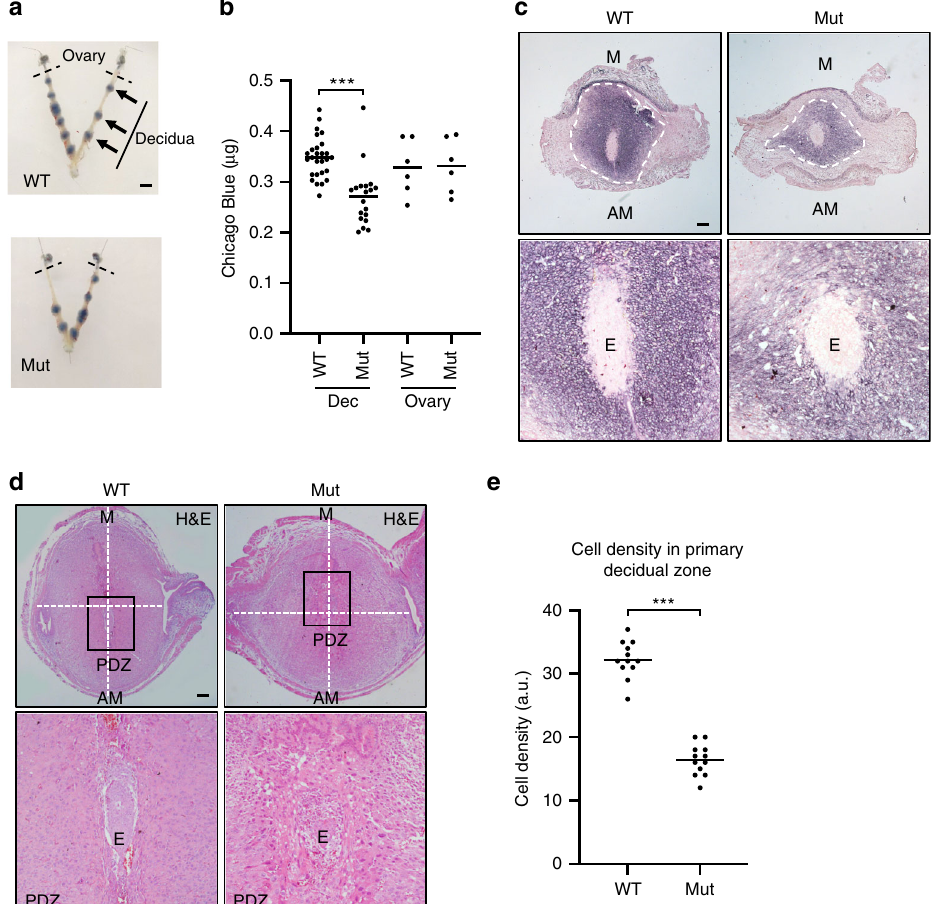
Fig. 2 Blimp1 mutants are receptive to implantation but display gross decidual and embryonic defects. a Sites of decidualisation at E6.5 appear grossly similar between wild-type and Blimp1 mutant uteri, as visualised by Chicago Blue dye injection ( n = 3 per group). b Chicago Blue content is reduced in decidua but not the ovaries of mutants (0.271 ± 0.013 μ g/decidua) in comparison to wild type (0.348 ± 0.008 μ g/decidua) mice. Data from 3 Blimp1 mutant mice (19 deciduae and 6 ovaries) and 3 wild-type mice (27 deciduae and 6 ovaries) are shown. Bars represent mean. Two-tailed unpaired Student ’ s t -test *** p = 3.49 × 10 − 6 . Source data are provided as a Source Data fi le. c Alkaline phosphatase staining of wild-type and Blimp1 mutant E5.5 decidua shows a reduction in intensity and the spread of alkaline phosphatase staining in Blimp1 mutant decidua indicative of impaired decidualisation ( n = 3 decidua per genotype). d H&E staining of E6.5 deciduae. Embryos in Blimp1 mutant mice are highly abnormal and display mis-localised implantation ( n = 4 decidua per genotype). e Cell density analysis of DAPI-stained nuclei identi fi es reduced cell density in the PDZ of Blimp1 mutants. Data from 12 tissue sections from four samples per genotype are shown. Bars represent mean. Two-tailed unpaired Student ’ s t -test *** p = 1.08 × 10 − 12 . Source data are provided as a Source Data fi le. PDZ = primary decidual zone, M = mesometrial, AM = antimesometrial, E = embryo. Scale bars = a 4 mm or c – d 100 μ